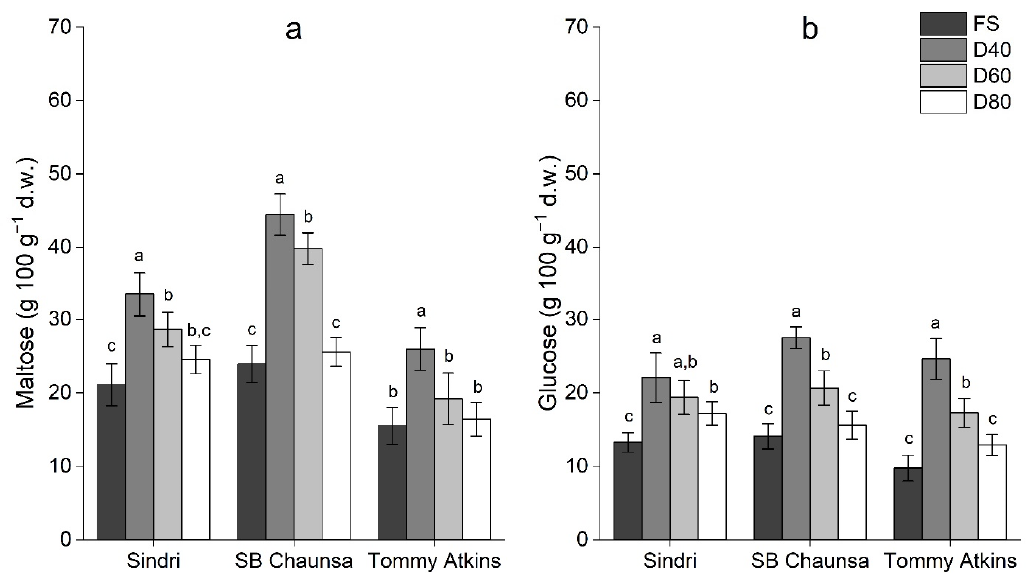
Figure 4. ( a ) Maltose and ( b ) glucose concentrations in fresh and dried samples of varieties Sindri, SB Chaunsa, and Tommy At kins; FS = fresh samples, D = dried samples, at temperatures 40 °C, 60 °C, and 80 °C. Different letters (a–c) above bars within the same variety represent significant differences p < 0.05, ( n = 6).